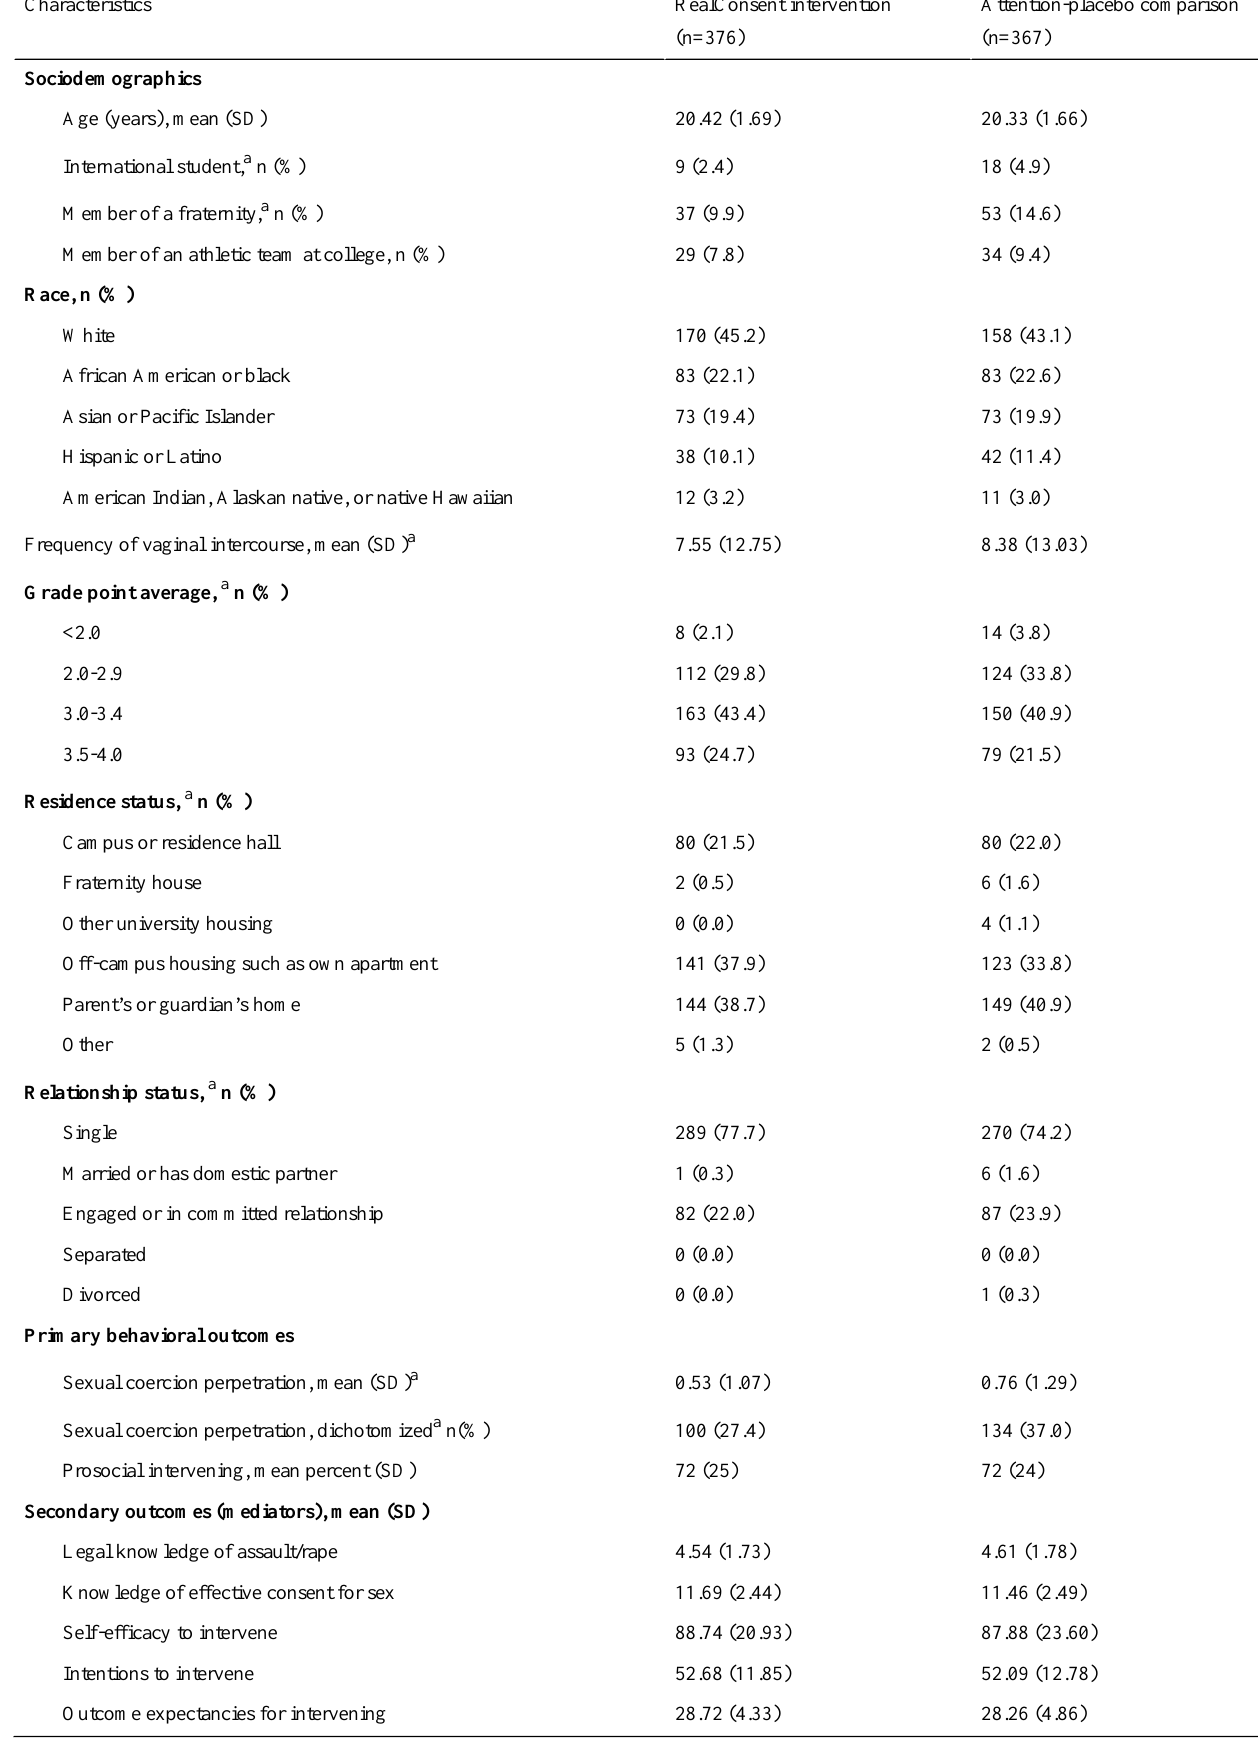
Table 2. Baseline equivalence of RealConsent and attention-placebo comparison condition participants